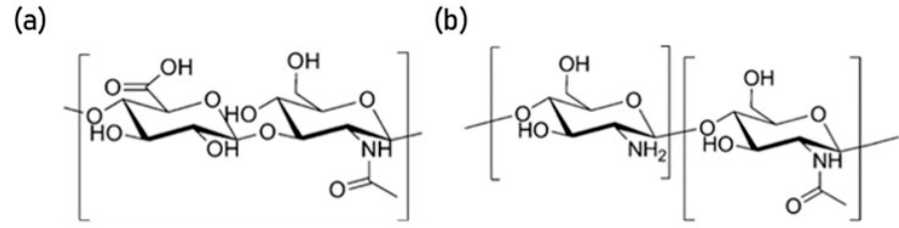
Figure 1. Molecular structure of ( a ) hyaluronic acid and ( b ) chitosan [34].